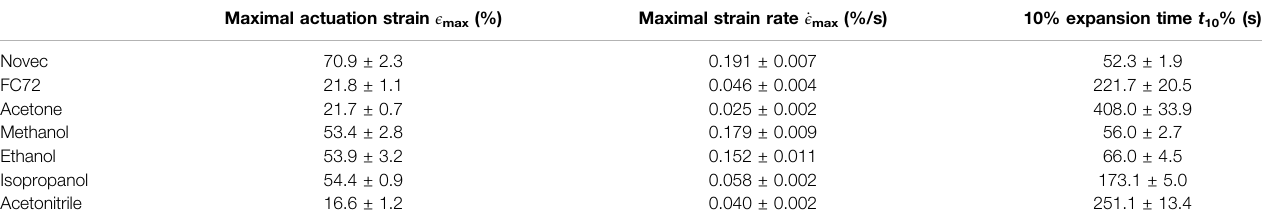
TABLE 3 | Maximal actuation strain, the strain rate, and actuation time for the different fl uids, response to a temperature step from room temperature to 30 ° C above the boiling point. Maximal actuation strain ϵ max (%)